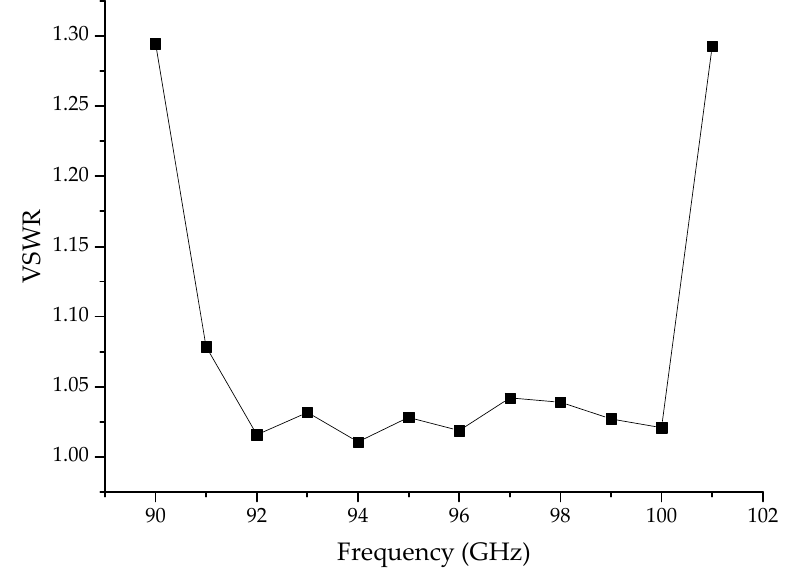
Figure 10. Calculated VSWR of the output window.